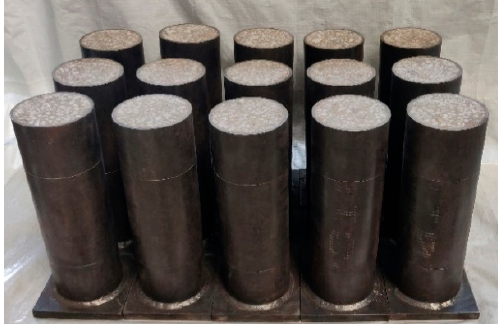
Figure 4. All specimens after pouring concrete.